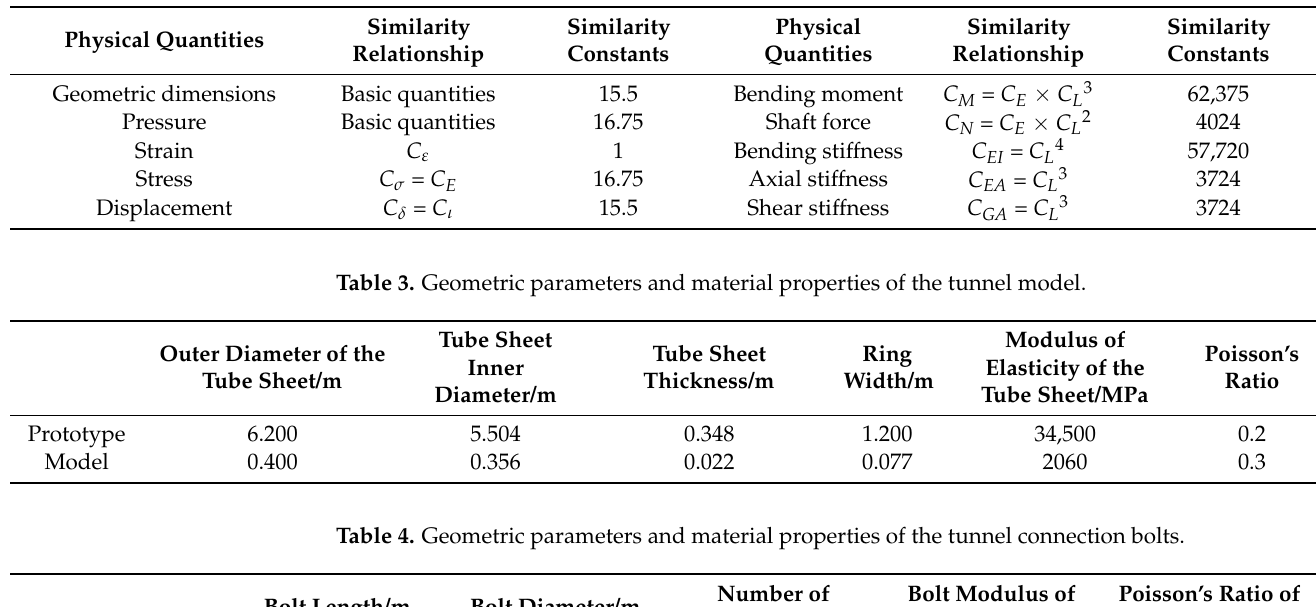
Figure 1. Model tunnel used for the test. Table 2. Similarity constants for the indoor model tests.